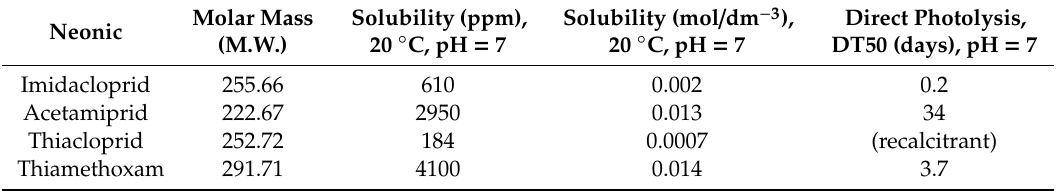
Table 1. Solubilities and photolytic rate of neonics in water (adapted and calculated from [28]). Molar Mass Solubility (ppm), Solubility (mol / dm − 3 ), Direct Photolysis, Neonic (M.W.) 20 ◦ C, pH = 7 20 ◦ C, pH = 7 DT50 (days), pH = 7 Imidacloprid 255.66 610 0.002 0.2 Acetamiprid 222.67 2950 0.013 34 Thiacloprid 252.72 184 0.0007 (recalcitrant) Thiamethoxam 291.71 4100